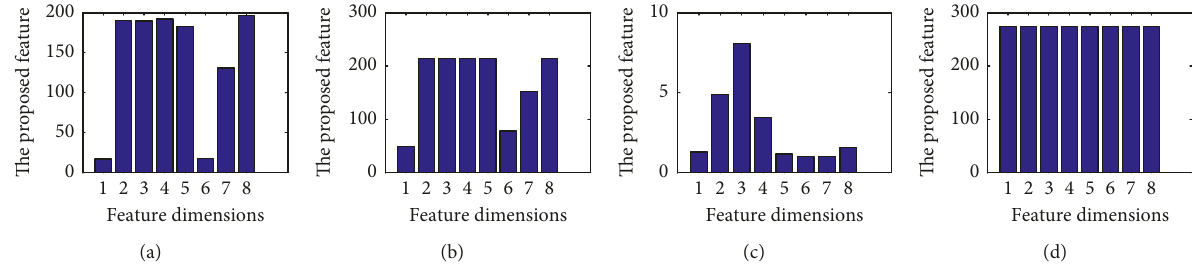
Figure 7:16D subnetwork average degree. (a) Feature of rolling element fault. (b) Feature of inner ring fault. (c) Feature of outer ring fault. (d) Feature of normal.